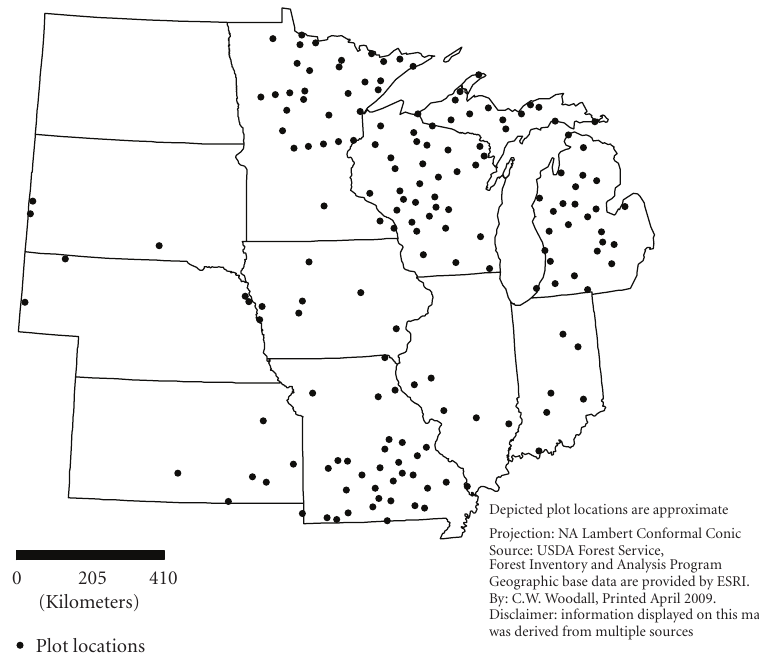
Figure 1: Study plot approximate locations across the north central United States, 2002 to